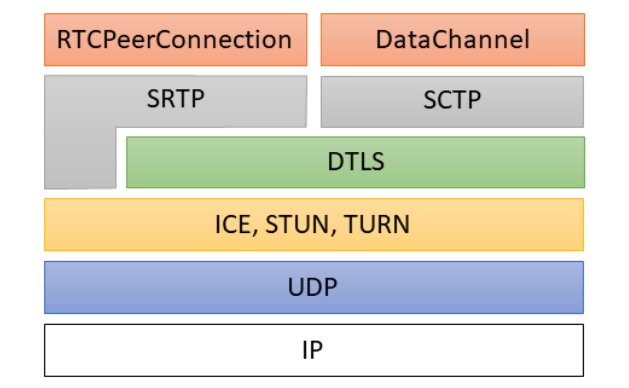
Figure 1. Web Real-Time Communications (WebRTC) protocol